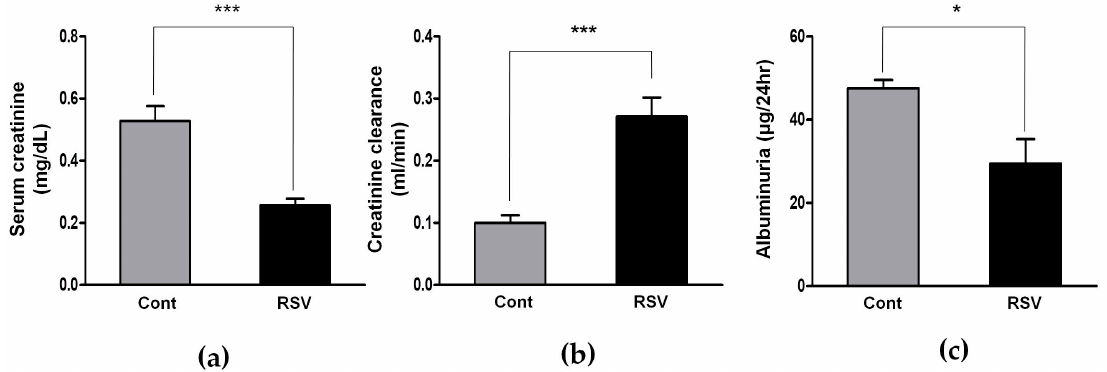
Figure 1. Effects of resveratrol on renal function of eighteen-month-old male C57BL/6 mice. Compared to the control group, resveratrol group showed ( a ) lower serum creatinine, ( b ) increased creatinine clearance, and ( c ) reduced 24 h albuminuria (* p < 0.05, *** p < 0.001).